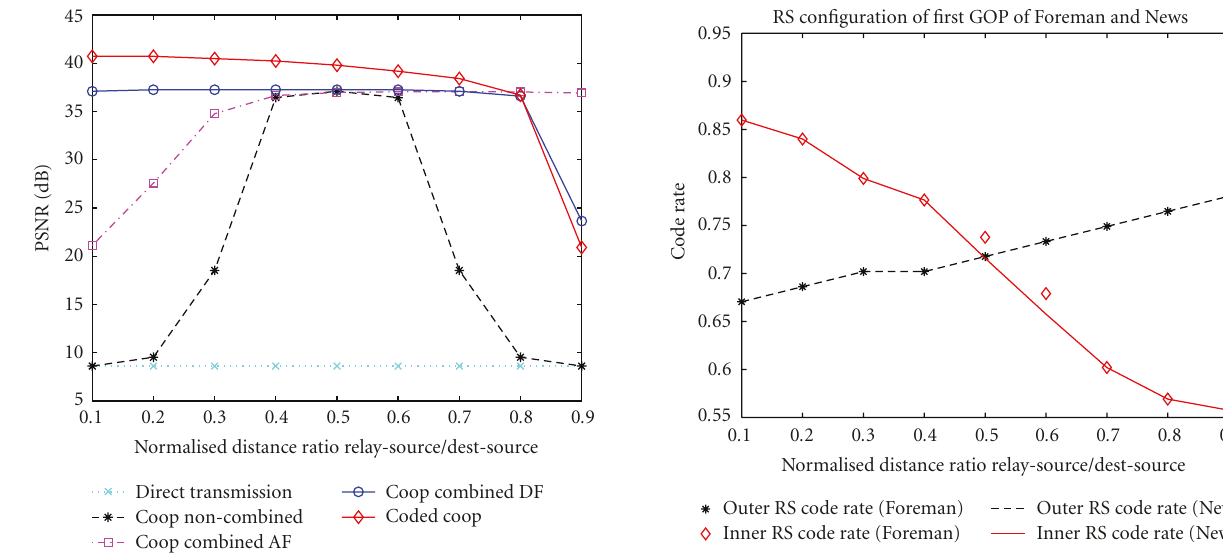
Figure 3: PSNR versus Relay Location (Video News).